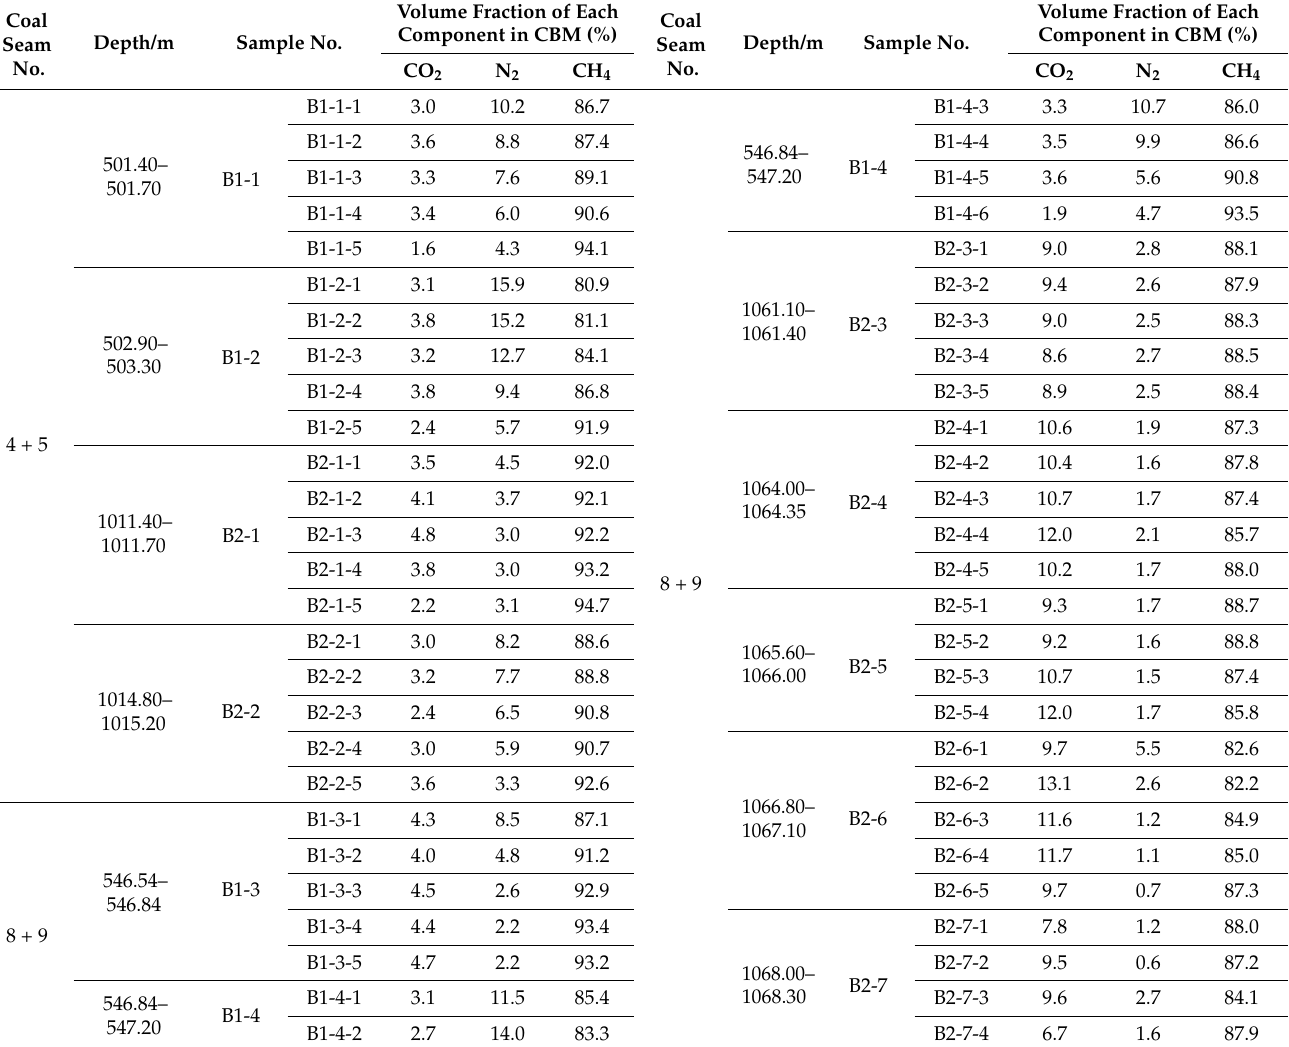
Table 2. CBM composition of the collected gas samples from eleven desorption tanks in different desorption